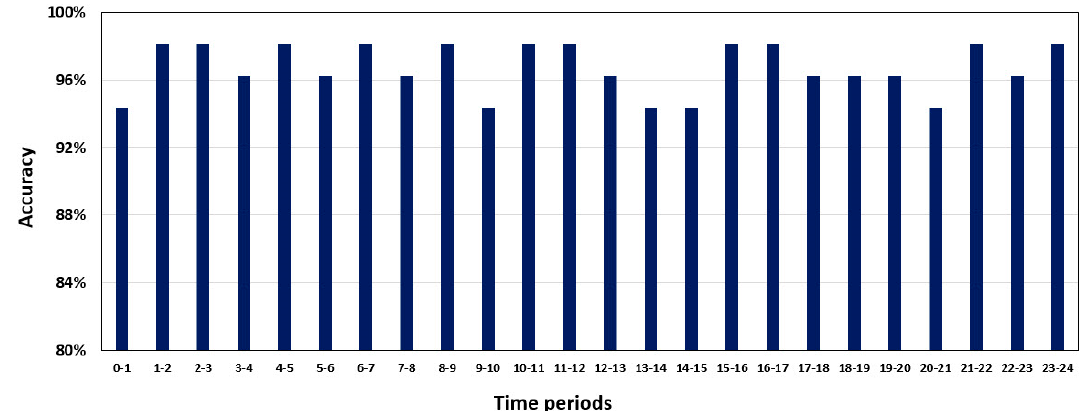
Figure 11. The accuracies of the data set of the OOO analyzing network in extended period conditions.